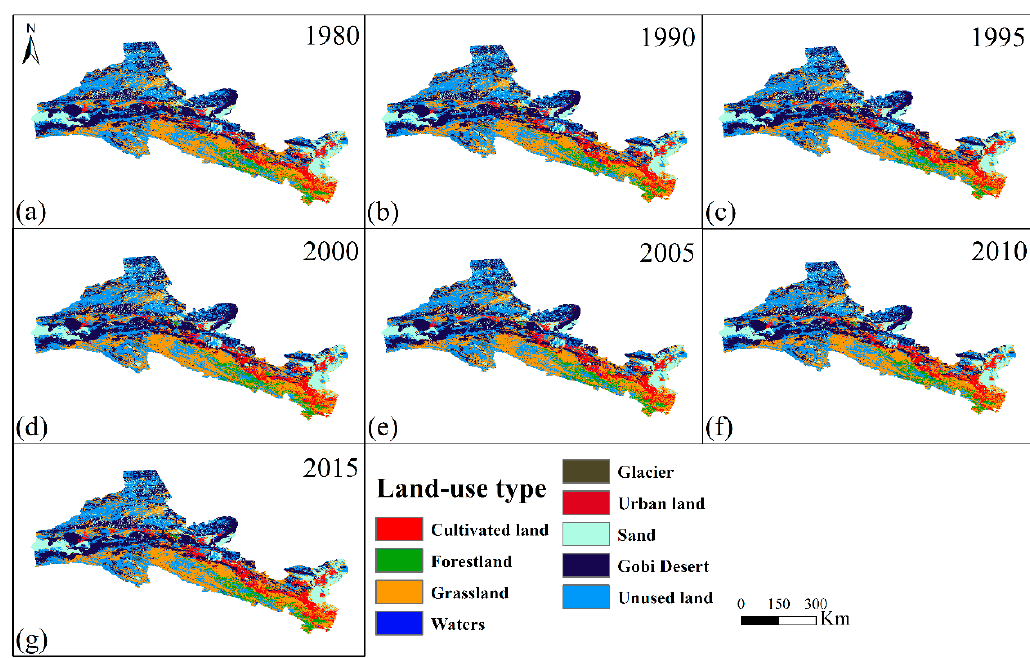
Figure 2. The land-use type map of the Hexi inland rivers basin: ( a ) 1980; ( b ) 1990; ( c ) 1995; ( d ) 2000; ( e ) 2005; ( f ) 2010; ( g ) 2015.